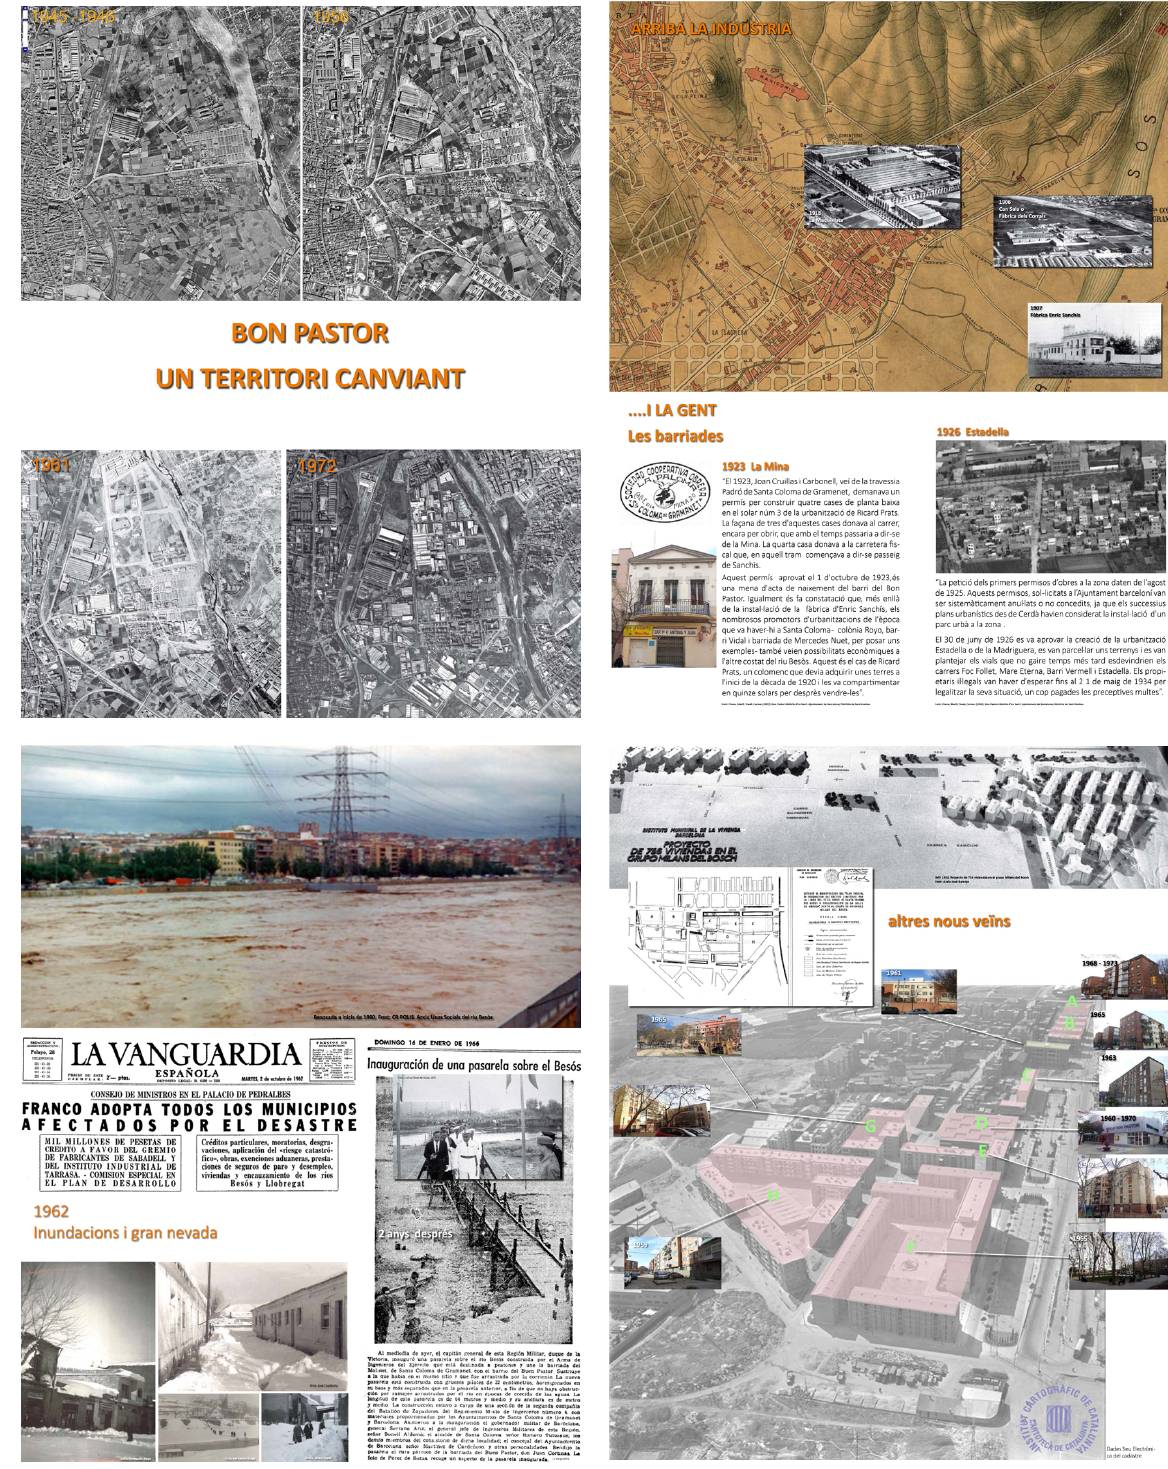
Four of the 15 panels that make up the first exhibition of the Fem la memòria Archive. The exhibition looks at the changing aspect of the neighbourhood from the early 20th century to the